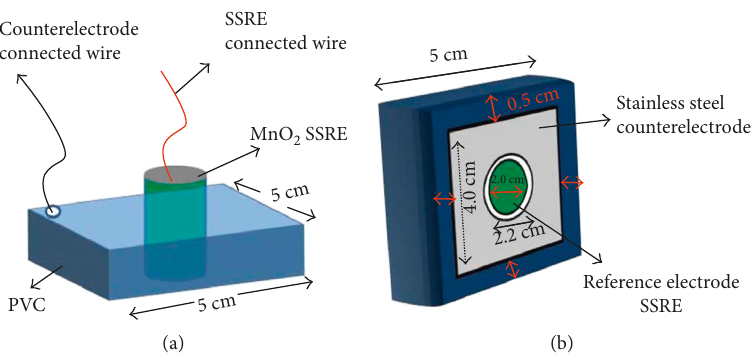
Figure 1: Schematic diagram of the ECMP [17]. (a) Top view. (b) Side view.